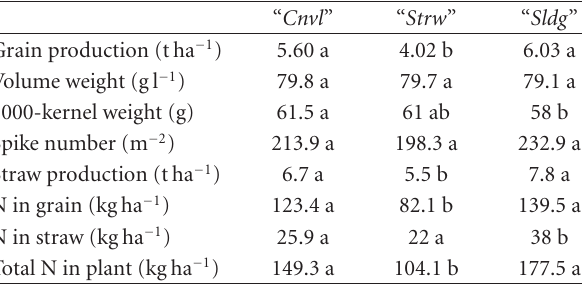
Table 2: Mean values of grain and straw yields, grain yield components, and N concentrations in the plant parts harvested after the first year of experimentation. Values followed by the same letter do not show statistically significant di ff erences between treatments at P < 0 .